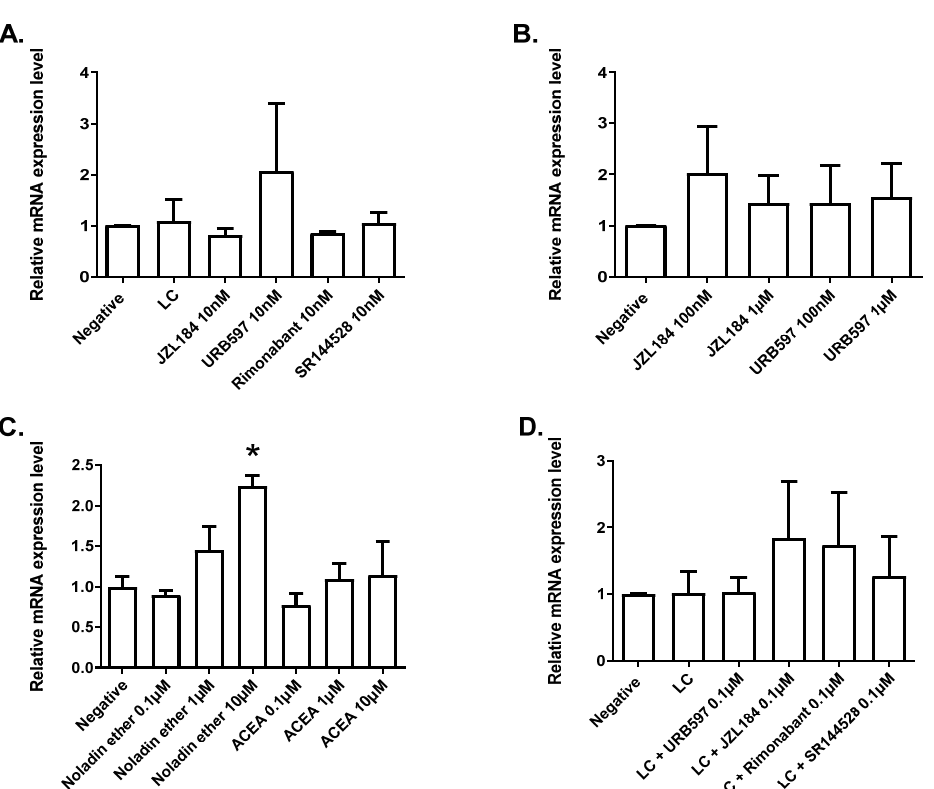
Figure 3. Expression in the duodenum-derived intestinal organoids. Relative Leap2 gene expression was measured by qPCR in organoids treated with the indicated compounds at the indicated concentra- tions to test responsiveness to cannabinoid receptor activity through pharmacological manipulation (( A – C ), Rimonabant; CB1 antagonist, SR144528; CB2 antagonist, URB597; FAAH inhibitor, JZL184; MGLL inhibitor) and in response to an inflammatory lipopolysaccharide/cytokine cocktail (( D ), LC; lipopolysaccharide [LPS, 10 µ g/mL], tumor necrosis factor-alpha [TNF α , 100 ng/mL), interleukin 1 beta [IL-1 β ; 100 ng/mL] and interferon-gamma [IFN γ , 100 ng/mL]) for 24 h and then co-treated with the indicated compound for a further 24 h. Experiments were performed in duplicate or in triplicate with organoids from at least 3 independent organoid cultures (n = 3–5). Each culture was isolated from the duodenum of different mice. Values are represented as mean ± S.E.M and were compared relative to control (Negative; without DMSO). * p ≤ 0.005 vs. DMSO.